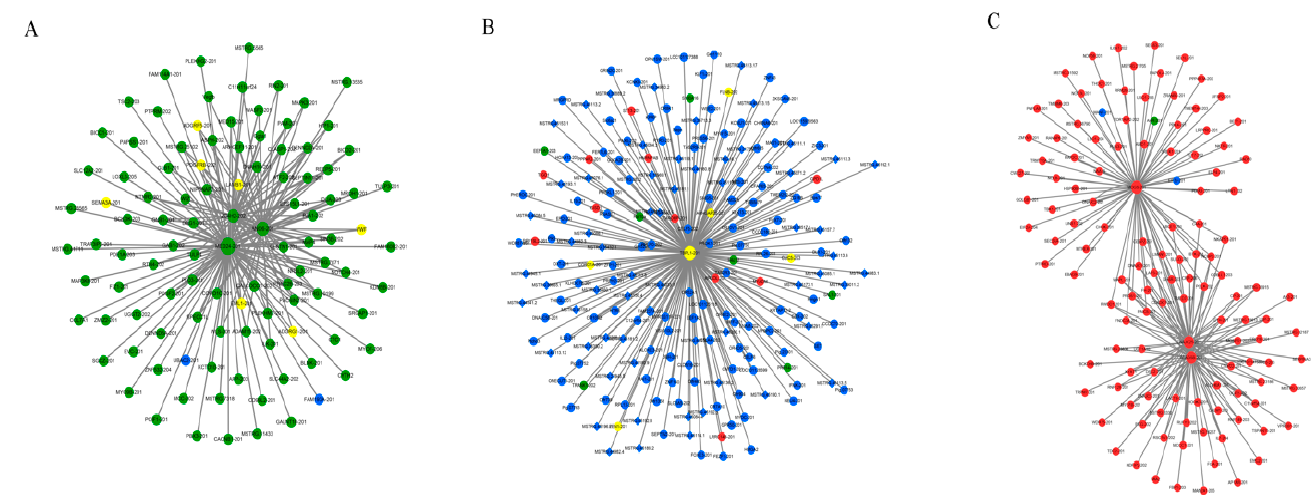
Figure 6. Co-expression network of mRNAs and lncRNAs in ( A ) molecular function module, ( B ) cellular component module, and ( C ) biological process module. Rhombic and circular nodes indicate mRNA and lncRNA, respectively. Color represents differential expression level: yellow: both upregulation and downregulation in development; red: upregulation: green: downregulation; blue: no changes.